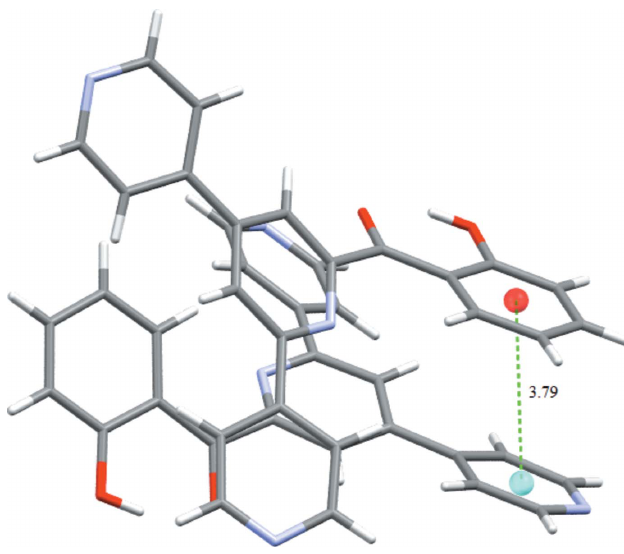
Figure 4 Unit-cell packing depicting the intermolecular (cid:2) – (cid:2) stacking interactions as dotted